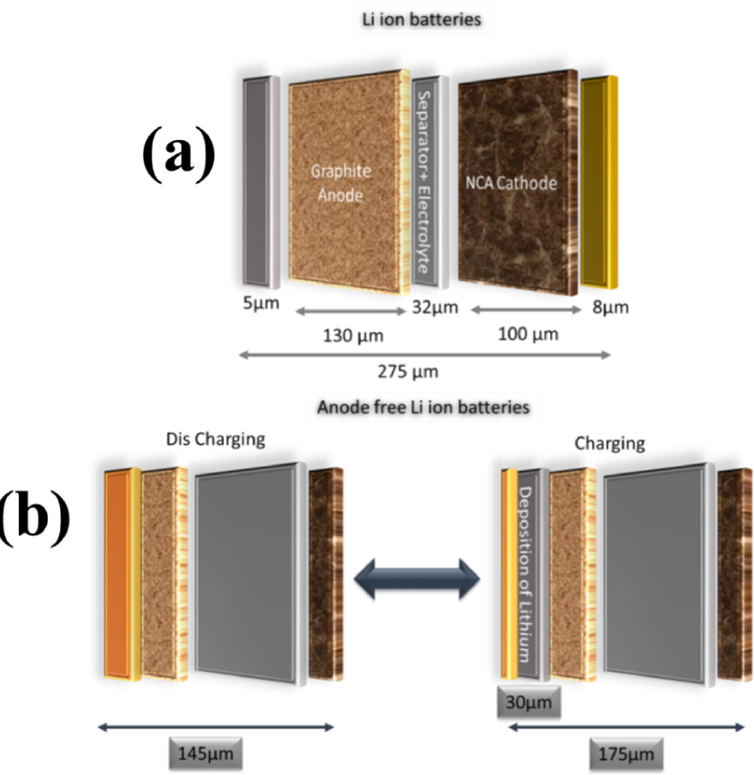
Figure 3. Schematic diagram of the loading of LIBs featuring an NCA (lithium–nickel–cobalt–aluminum oxide) cathode system with a thickness of 100 µ m. ( a ) Schematic illustration of an example lithium-ion battery using an NCA cathode of thickness 100 µ m and a loading of 30.5 mg · cm − 2 , drawn to scale. ( b ) Schematic illustration of an anode-free full cell using an equivalent NCA cathode, in both charged and discharged states. The difference in energy density can be clearly visualized. There is a ~20% volume change associated with the plating and stripping of lithium, which will have to be accommodated (modified from [30]).